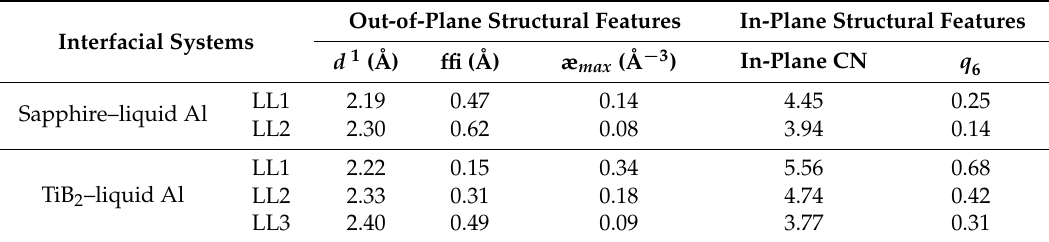
Figure 2. Atomic density profiles (averaged from 3–6 ps) along the z -direction of the (0001) sapphire–liquid Al and the (0001) TiB 2 –liquid Al interfaces. The first liquid layers (LL1) of these two systems are aligned to z = 0. Table 1. Main results showing the out-of-plane and in-plane structural features of the substrate-induced liquid layers.